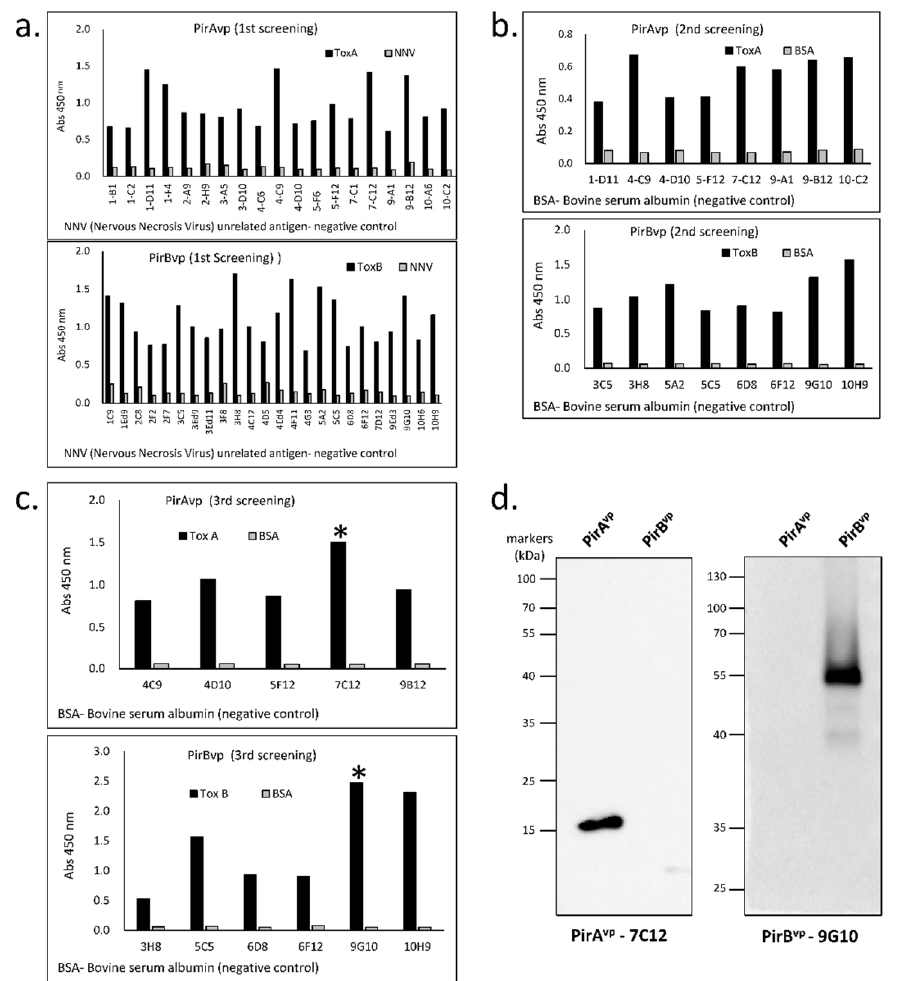
Figure 2. ELISA screening and Western blotting of recombinant VLRBs to check specificity to PirA vp and PirB vp . ( a ) first screening, ( b ) second screening, ( c ) third screening, and ( d ) blotting results show specificity of the VLRBs, PirA vp -7C12, and PirB vp -9G10, with band size 15 kDa and 55 kDa, corresponding to PirA vp and PirB vp , respectively. The * corresponds to the respective VLRB-specific PirA vp and PirB vp used in succeeding experiments.